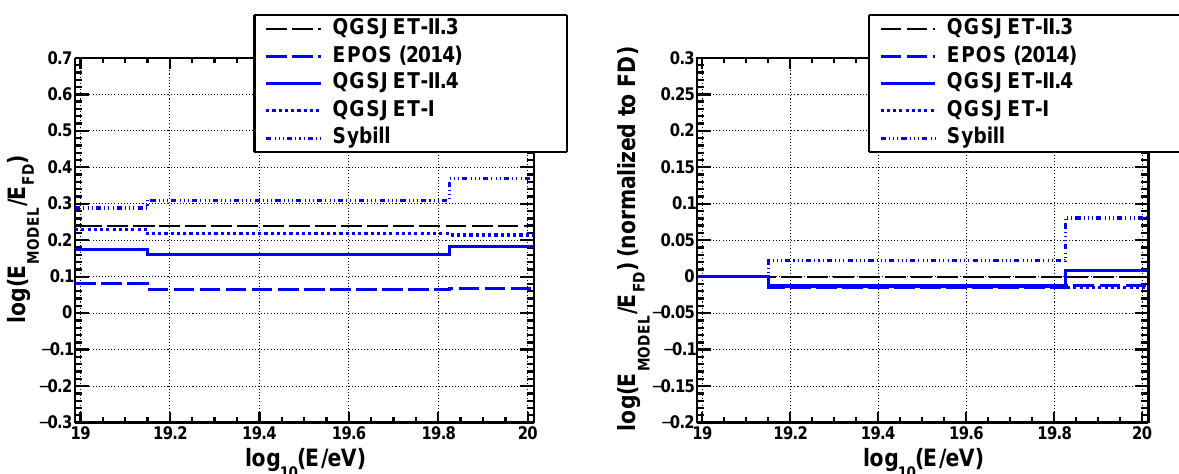
Figure 3. (LEFT): SD to FD calibration factors for a various hadronic interaction models (proton composition) as functions of true (Monte Carlo) energy. Same SD to FD calibration factors after dividing out the overall constants. In the extreme case of Sybill, the energy non-linearity is within 10% per decade of energy.